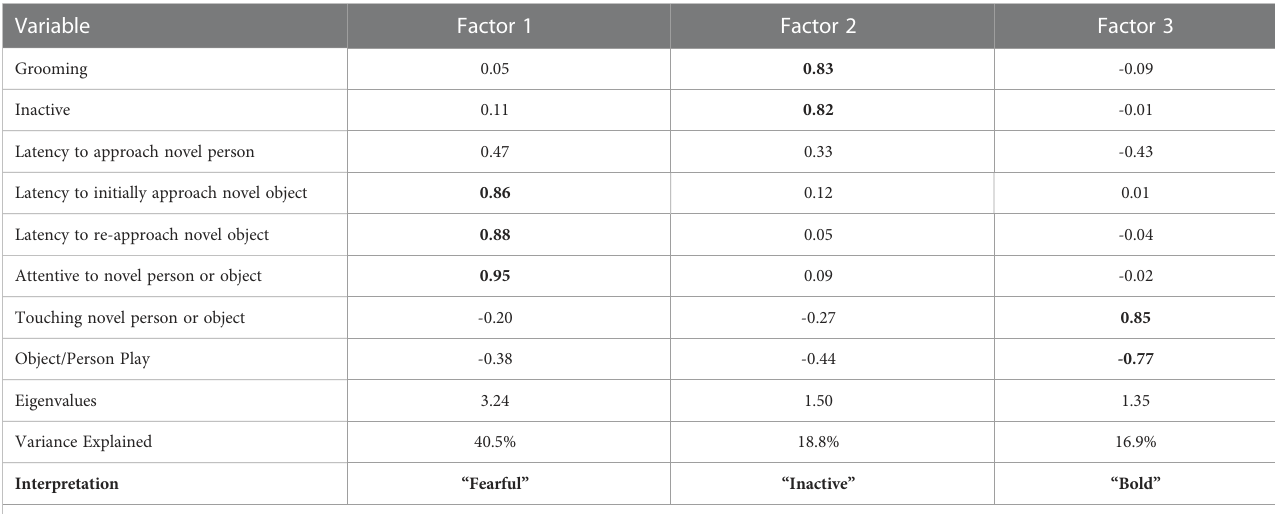
TABLE 3 Coef fi cients (loadings) of each variable for the fi rst 3 factors extracted from the principal component analysis of the behavioral responses of Holstein x Angus crossbred calves (n = 29) in the standardized personality tests.